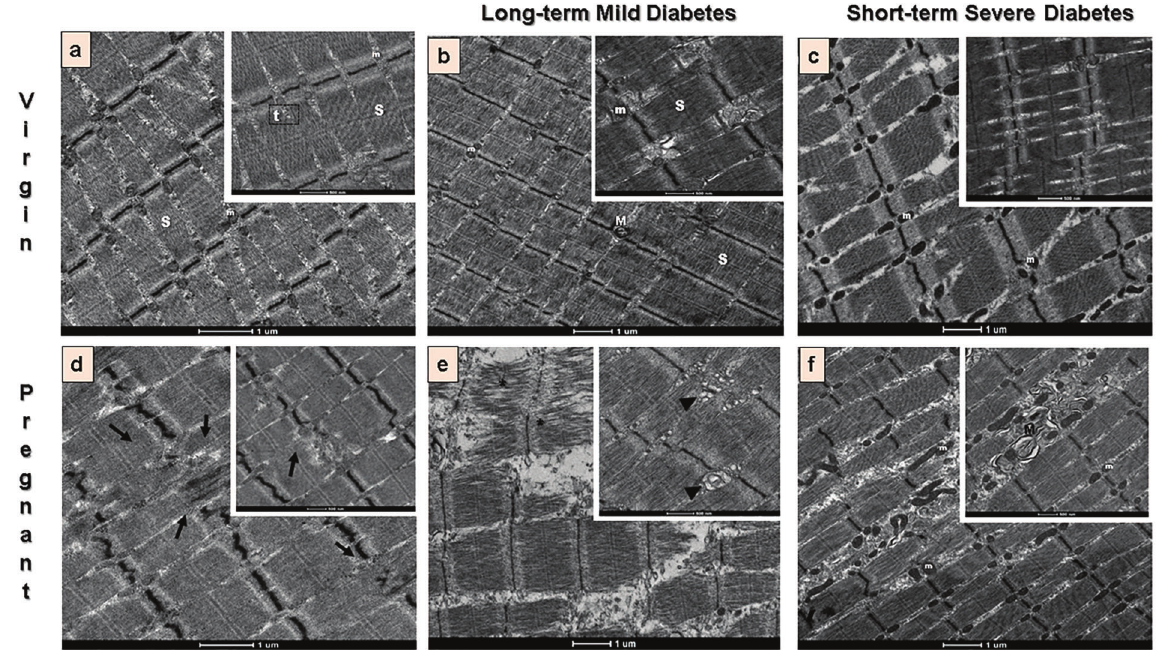
Figure 4. Electron micrographs of rat rectus abdominis muscle fi bers from virgin ( a ), long-term mild diabetic ( b ), short-term severe diabetic ( c ), pregnant ( d ), long-term mild diabetic pregnant ( e ), and short-term severe diabetic pregnant ( f ) animals. The micrographs show mitochondria (m), myelin fi gures (M), well-organized myo fi brils forming intact sarcomeres (S) and a system formed by sarcoplasmic reticulum and t tubule-triads (t), areas with disorganized Z lines and thinning sarcomeres (arrows), swollen sarcoplasmic reticulum and dilated T tubes (arrowheads) and areas with disrupted sarcomeres (*). Inset scale bar: 500